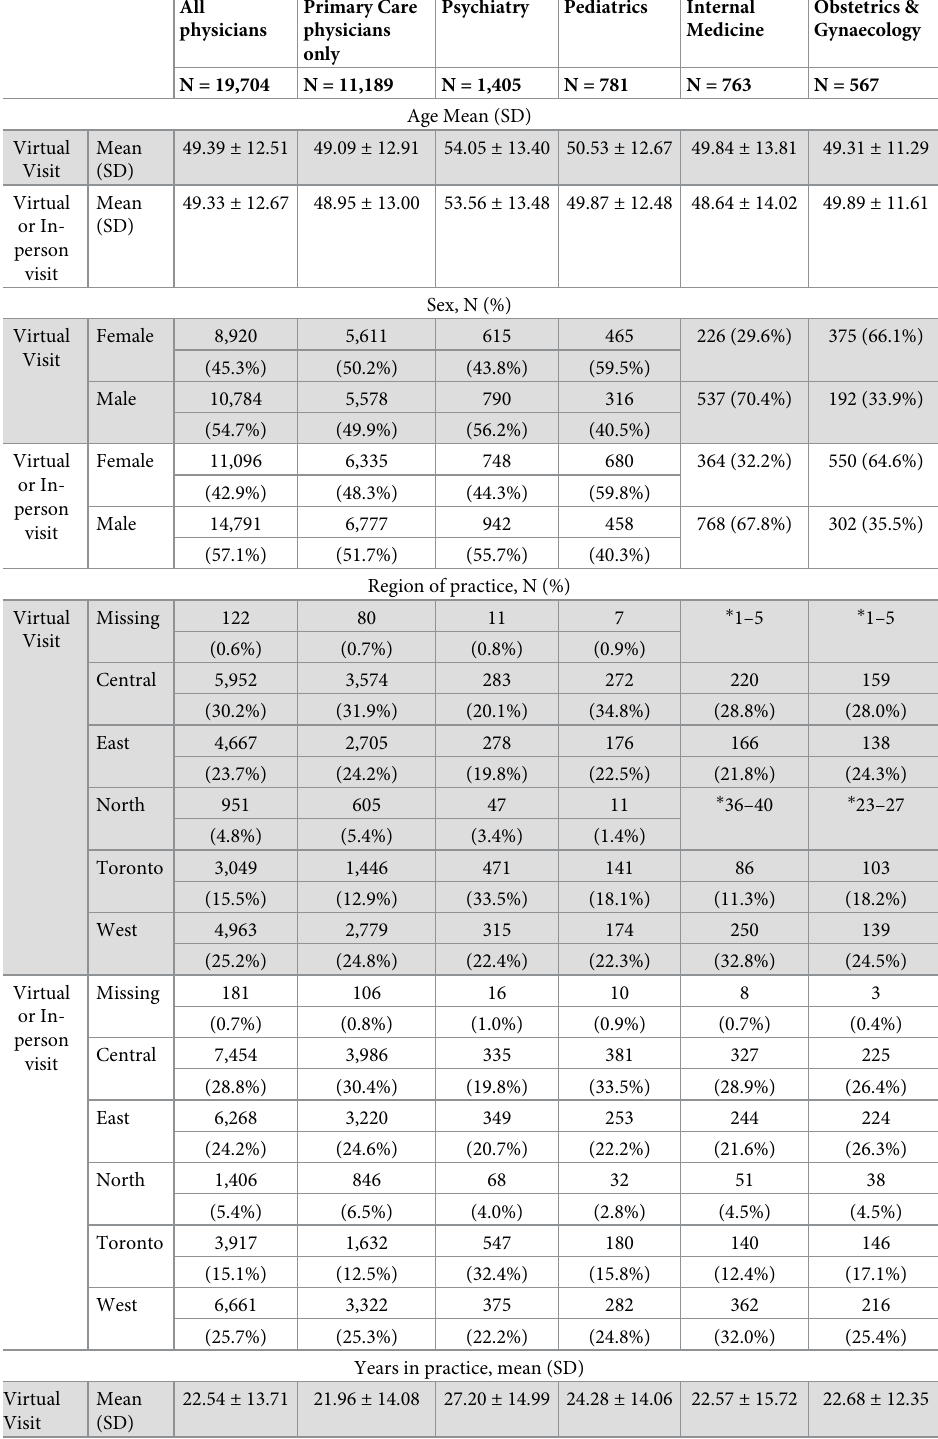
Table 5. Comparison of physicians who provided the last outpatient visit before ED admissions across care modalities (virtual vs. virtual or in-person) in July 1, 2021- September 30, 2021, Mean ± SD. All